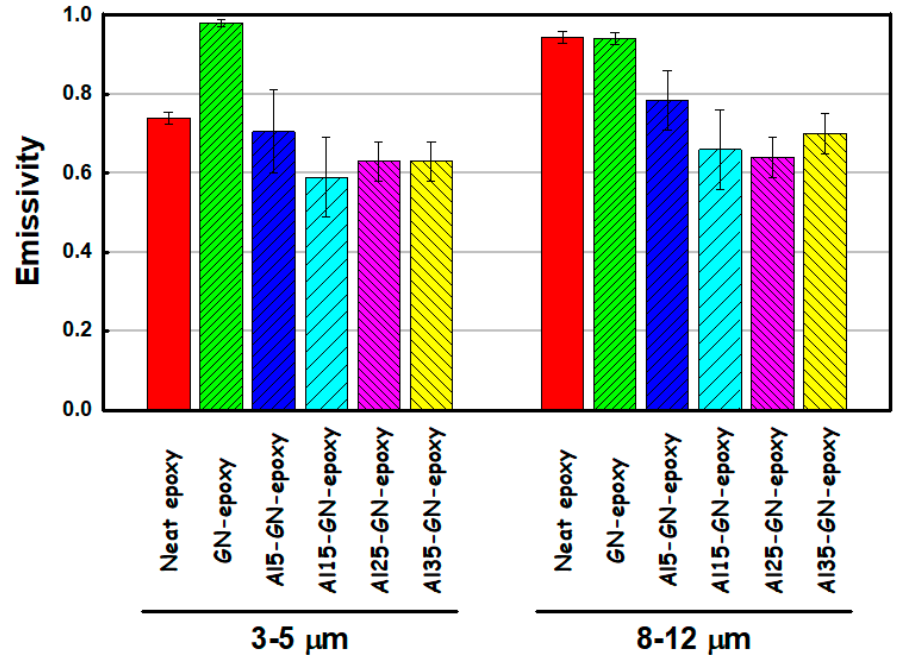
Figure 19. Average thermal emissivity values in the 3–5 and 8–12 μ m windows for the neat epoxy, GN 0.05 -epoxy and Al-GN 0.05 -epoxy coatings with various Al contents (5, 15, 25 and 35 wt.%).